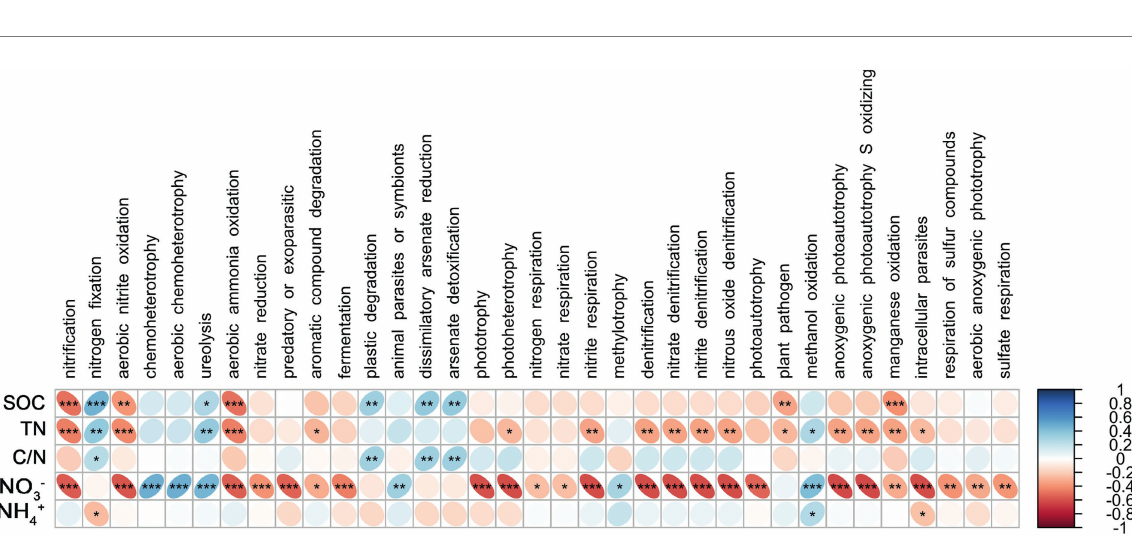
FIGURE 5 Correlations between predicted bacterial functional groups of the rhizosphere and soil organic carbon (SOC), total nitrogen (TN), C/N ratio (C/N), soil nitrate nitrogen (NO 3 − ), and ammonia nitrogen (NH 4+ ) levels based on Spearman’s rank correlation. Significant difference were indicated as follows: * p < 0.05; ** p < 0.01; *** p <